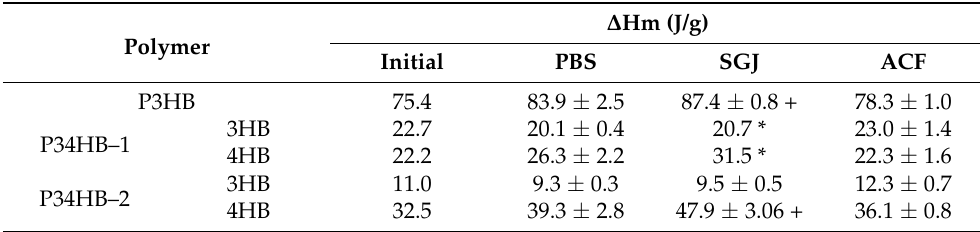
Table 3. Melting enthalpy of the initial and final state of the films.